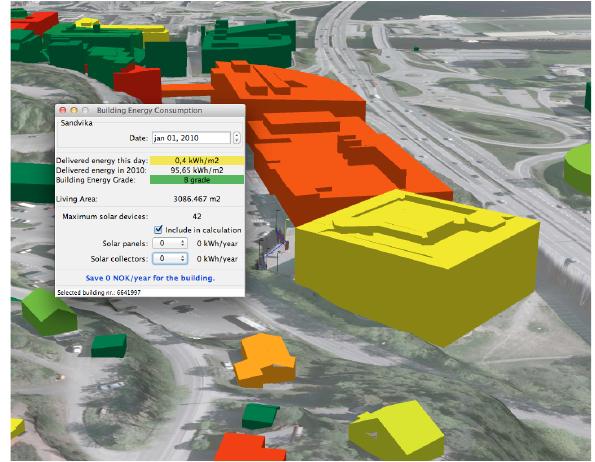
Figure 7. Energy consumption for selected building